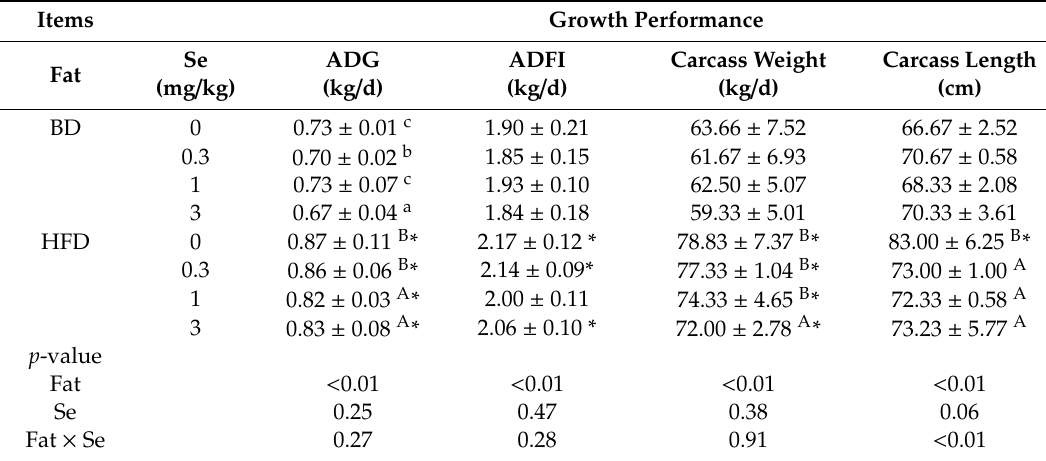
Table 3. Results of the growth performance.